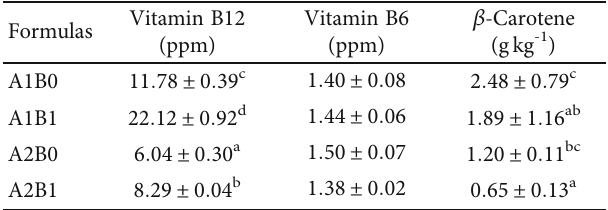
Values are mean ± SD from three replications; the di ff erent superscripts in one column denote signi fi cant di ff erences ( p < 0 : 05 ). Table 6: Composition content of vitamin B12, vitamin B6, and β - carotene in cream soup formulas.